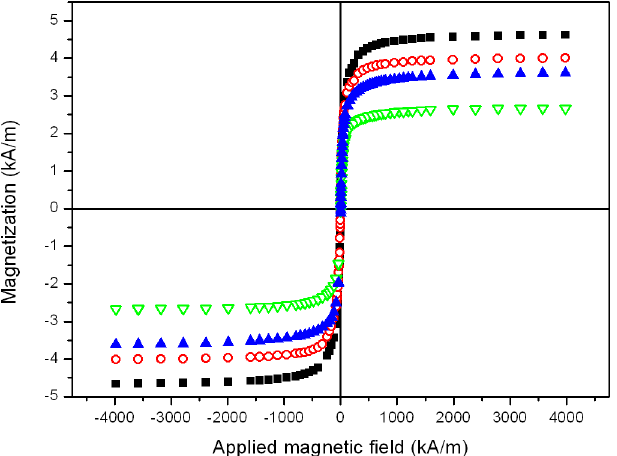
Fig 4. Magnetization curves of magnetic tissue substitutes. Filled squares: tissue substitute gelled in the absence of a magnetic field (M-MF0); open circles: tissue substitute gelled during application of a 16 kA m -1 field (M-MF16); open triangles: tissue substitute gelled during application of a 32 kA m -1 field (M-MF32); filled triangles: tissue substitute gelled during application of a 48 kA m -1 field (M-MF48). Values for saturation magnetization (kA/m) were obtained according to the Fröhlich – Kennely law [36]: M-MF0: 4.7 ± 0.3; M-MF16: 4.04 ± 0.24; M-MF32: 2.67 ± 0.15; M-MF48: 3.57 ± 0.20.